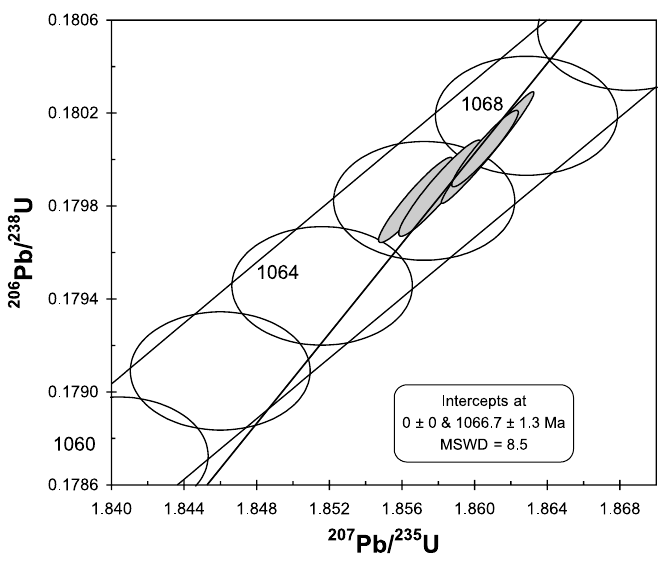
Fig. 3 – The U-Pb concordia diagram for 91500 standard using 235 U- 205 Pb “